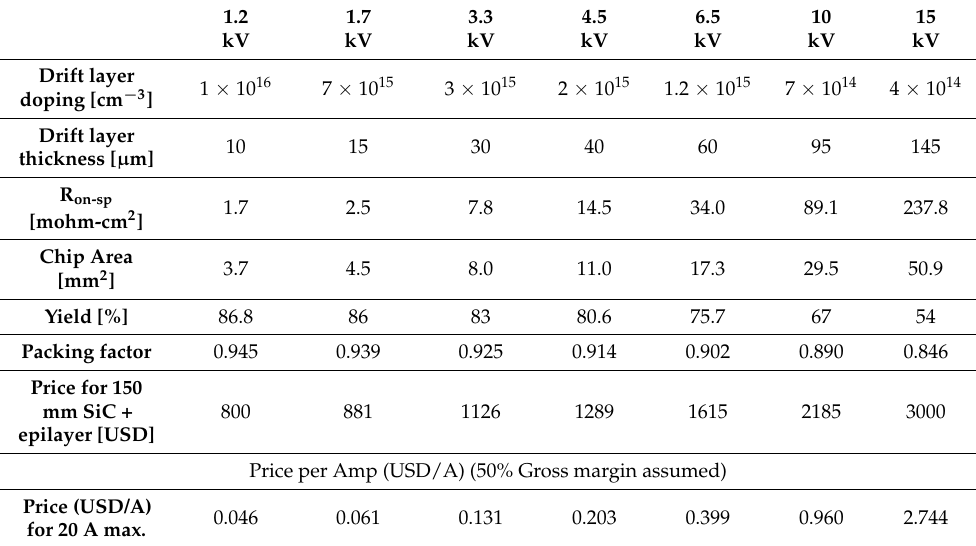
Table 4. Estimation of the price of SiC power MOSFETs at various voltage nodes for a 20 A chip in high volume hybrid Si/SiC foundry